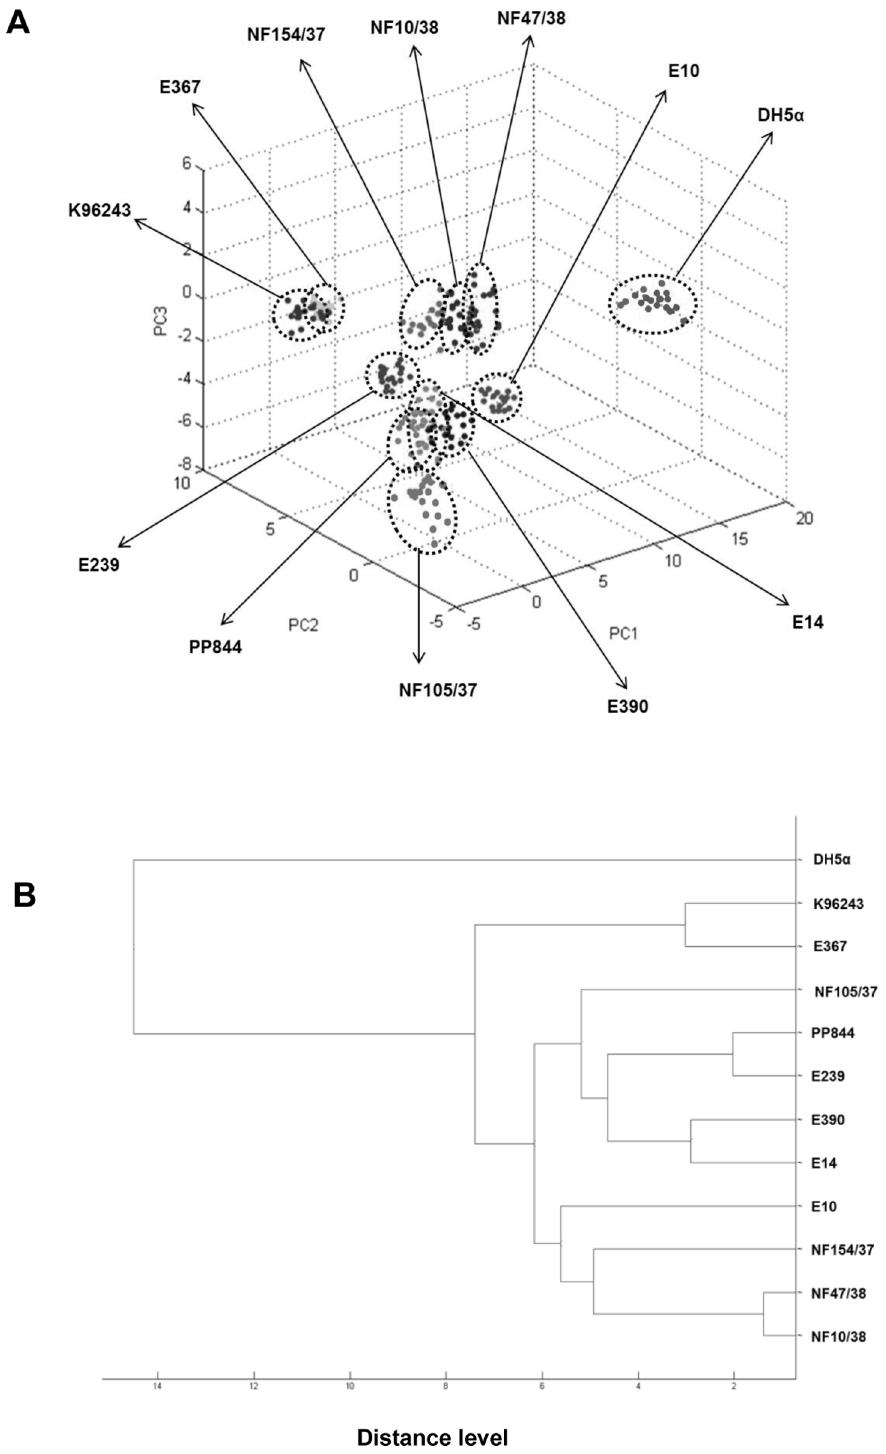
Figure 2. Principal component analysis (PCA) and cluster analysis of B.pseudomallei isolates. A) PCA analysis analyzed from total mass spectra showed intermixture and widely spreaded of all isolates from two source groups. B ) Dendrogram constructed from the scores of PCA demonstrated that three of six environmental isolates; E239, E390, and E14 were grouped on their own cluster. Similarly, three clinical isolates, consisting of NF154/37, NF47/38, and NF10/38, were clustered together. E. coli DH5 a was used as an outgroup taxon. Numbers shown in x-axis revealed distance level of tested isolates.